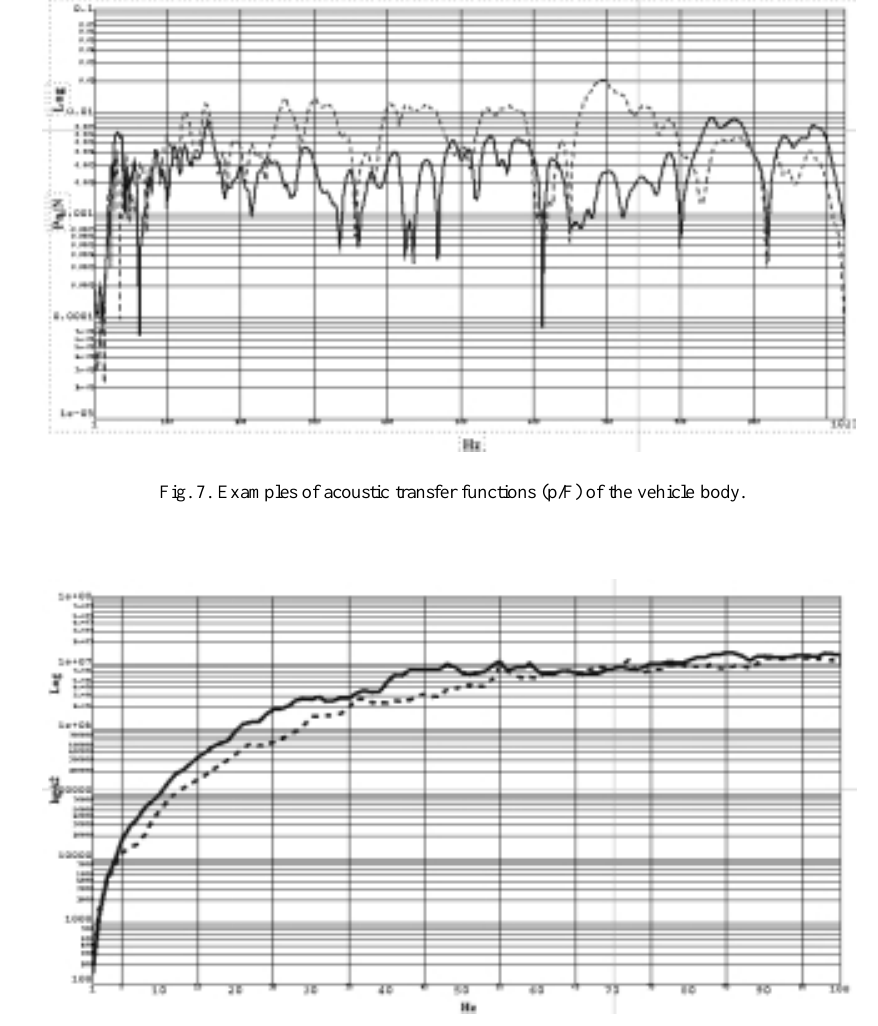
Fig. 8. Examples of frequency dependent stiffness of